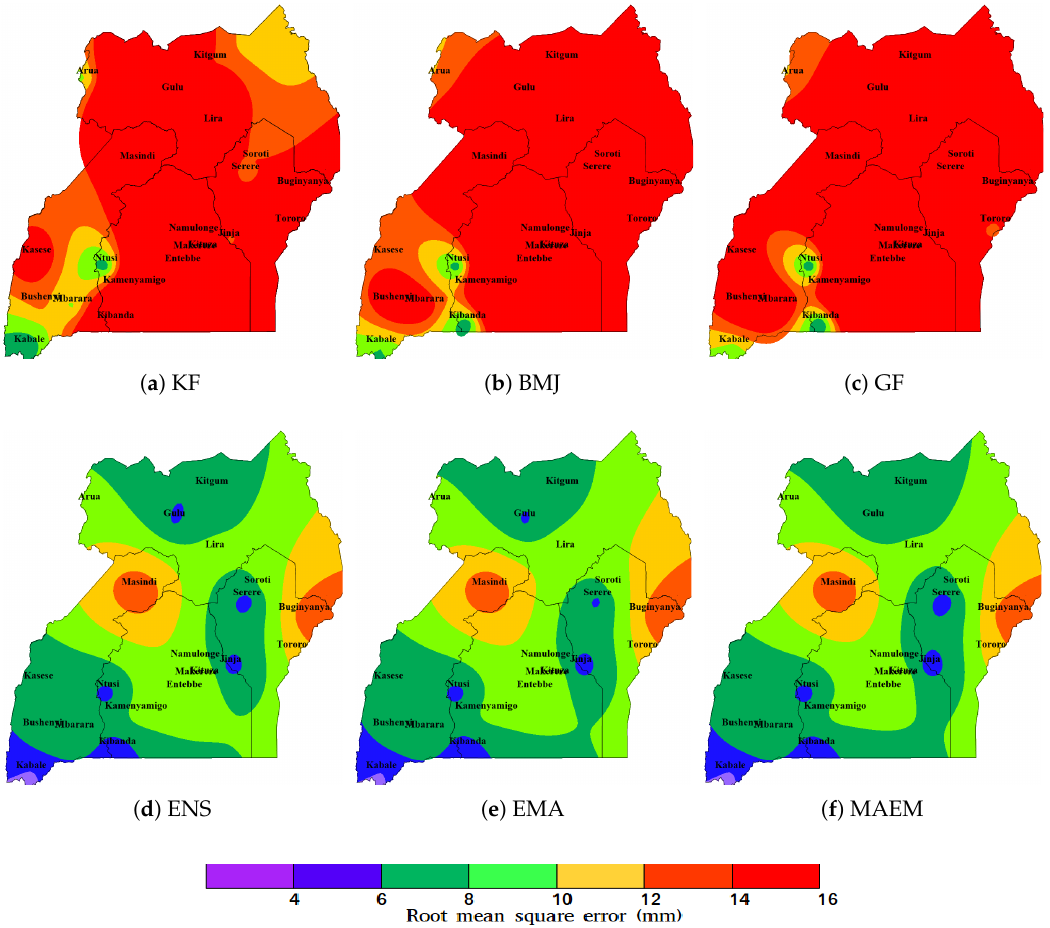
Figure 4. Shows the spatially interpolated RMSE using IDW of cumulus parameterization schemes: KF ( a ), GF ( b ), G3 ( c ) and the RMSE of the ensemble methods: ENS ( d ) , EMA ( e ) and MAEM ( f